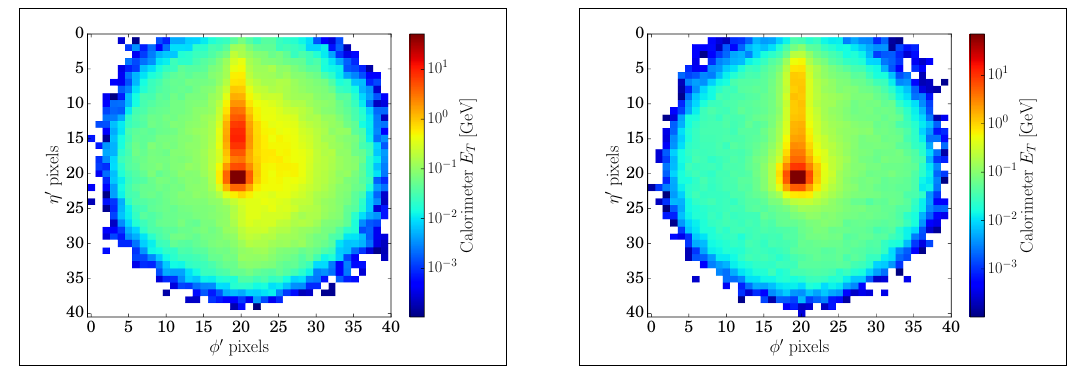
Figure 1 . Jet image after pre-processing for the signal (left) and background (right). Each picture is averaged over 10,000 actual